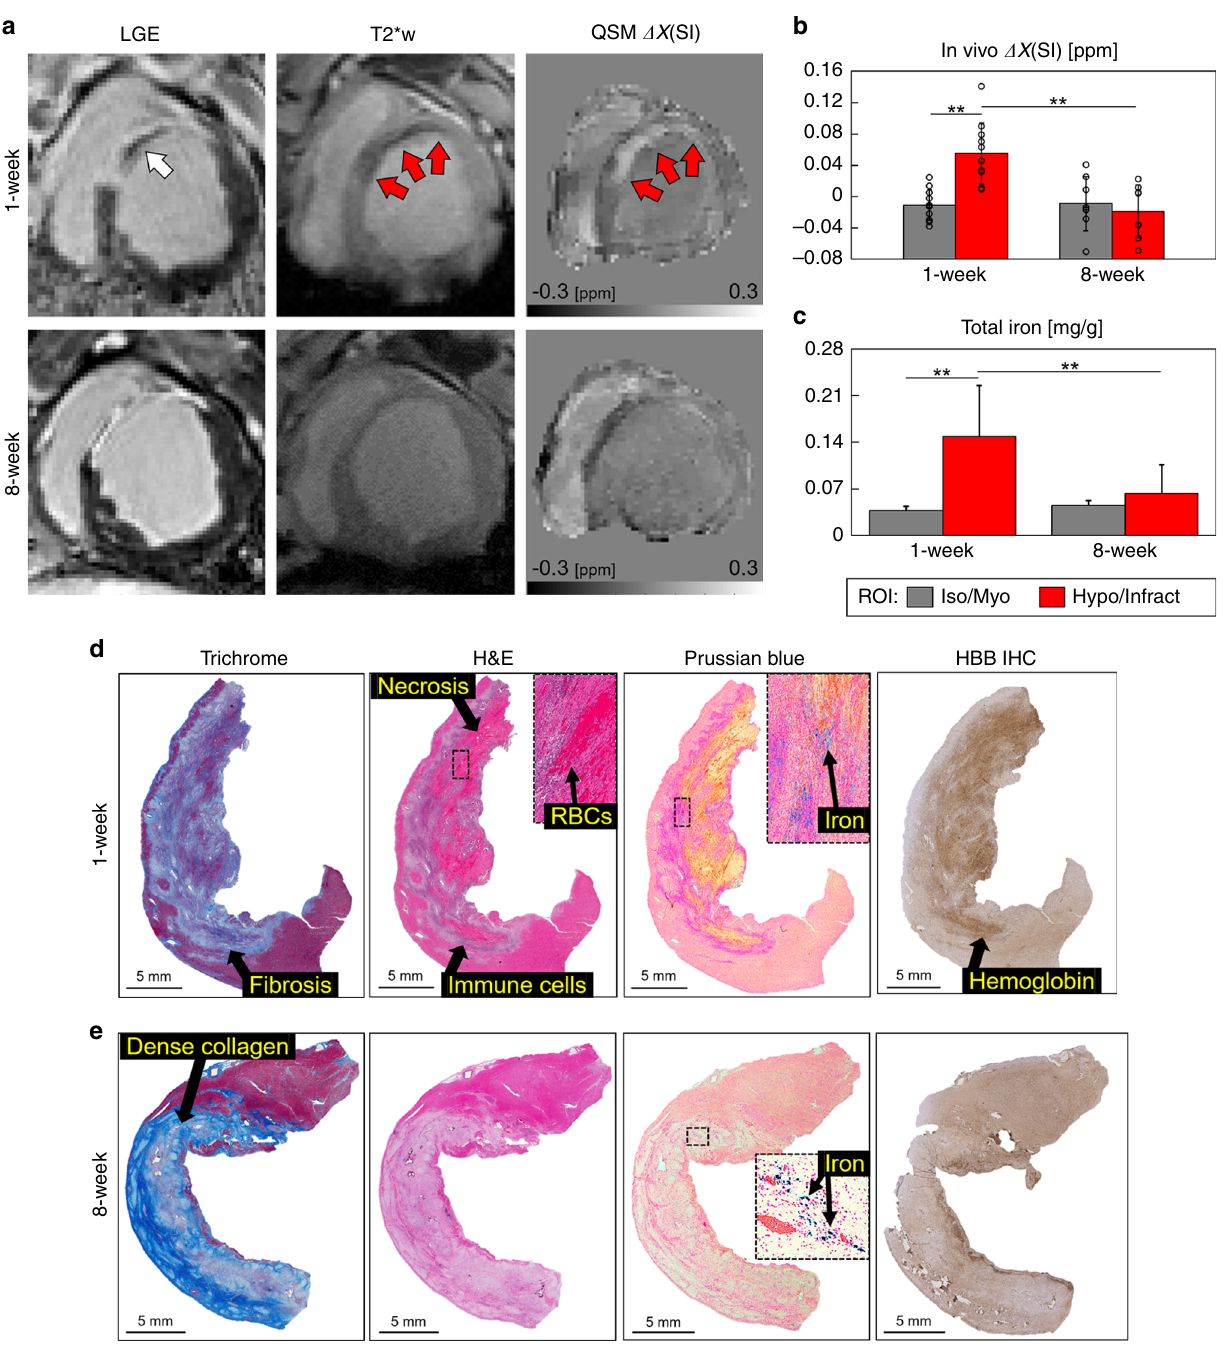
1 week there was a signi fi cant paramagnetic shift within the infarct region ( Δ χ = 0.055 ± 0.039 ppm) compared with the remote myocardium ( Δ χ = − 0.011 ± 0.020 ppm) ( P = 2e − 4) (Fig. 5b). This was associated with elevated total iron con- centration, measured by ICP-OES (infarct samples n = 68, [Fe] = 0.15 ± 0.08 mg/g vs. remote myocardium samples n = 80, [Fe] =